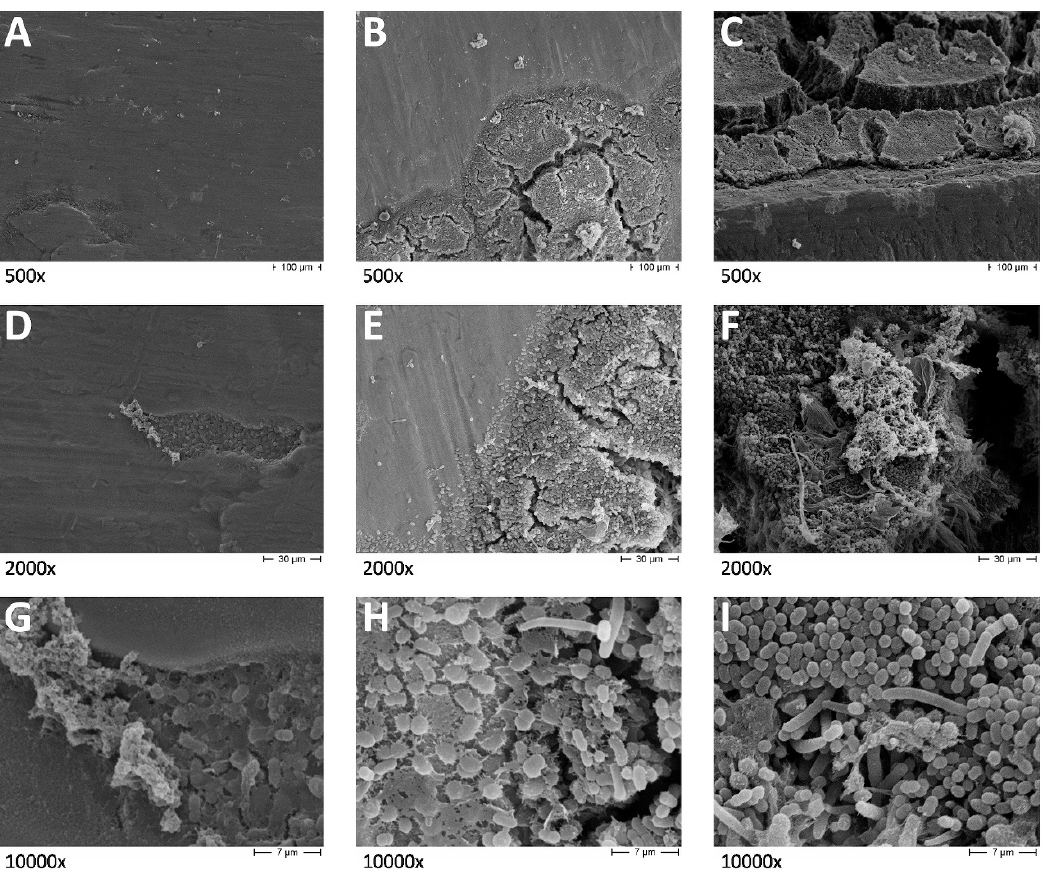
Figure 2. Scanning electron microscopy (SEM) micrographs of test. ( A ) test implant at 500 × magnifications; ( B ) bottom part of the test implant at 500 × magnifications; ( C ) control implant at 500 × magnifications; ( D ) test implant at 2000 × magnifications; ( E ) bottom part of the test implant at 2000 × magnifications; ( F ) control implant at 2000 × magnifications; ( G ) test implant at 10,000 × magnifications; ( H ) bottom part of the test implant at 10,000 × magnifications; ( I ) control implant at 10,000 × magnifications.